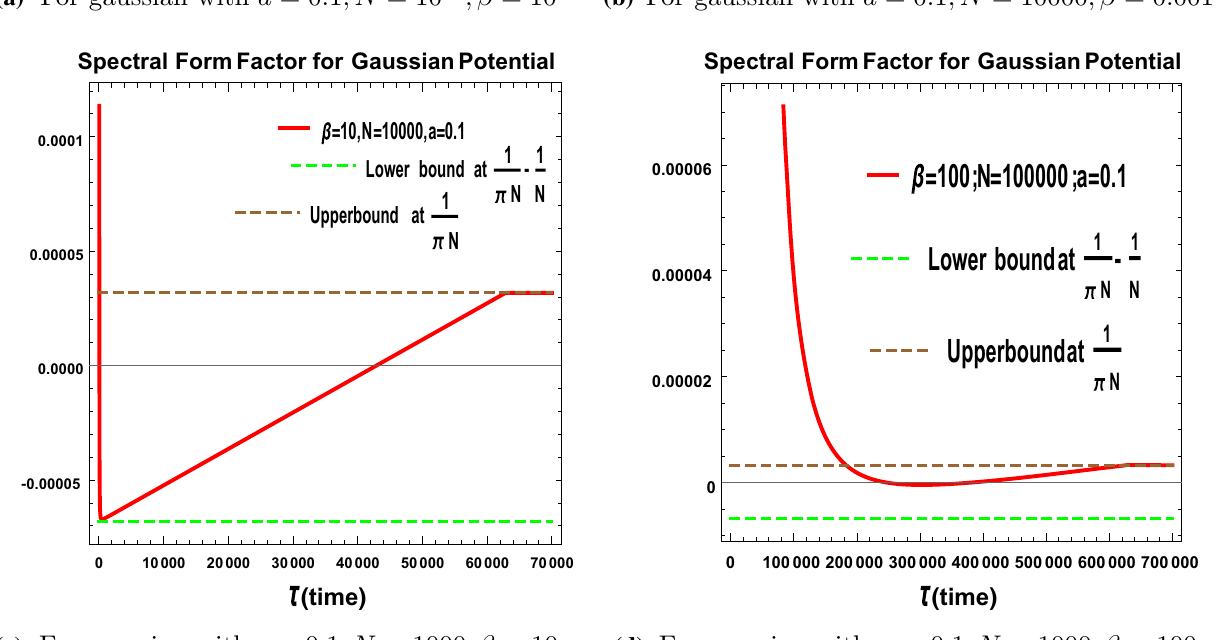
tion including the possible quantum effects (corrections)